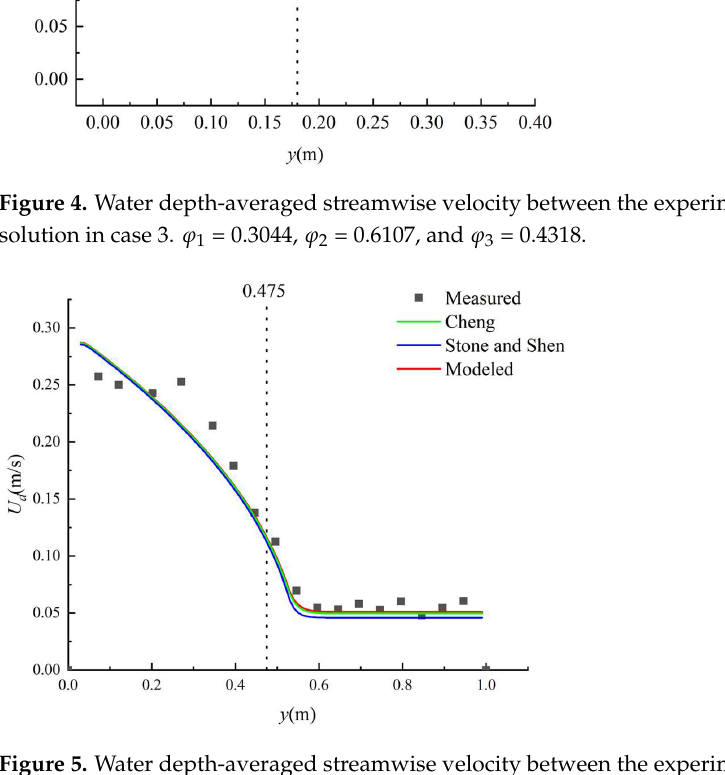
Figure 5. Water depth-averaged streamwise velocity between the experimental data and analytical solution in case 4; φ 1 = 0.8013, φ 2 = 0.8685, and φ 3 = 0.7778.